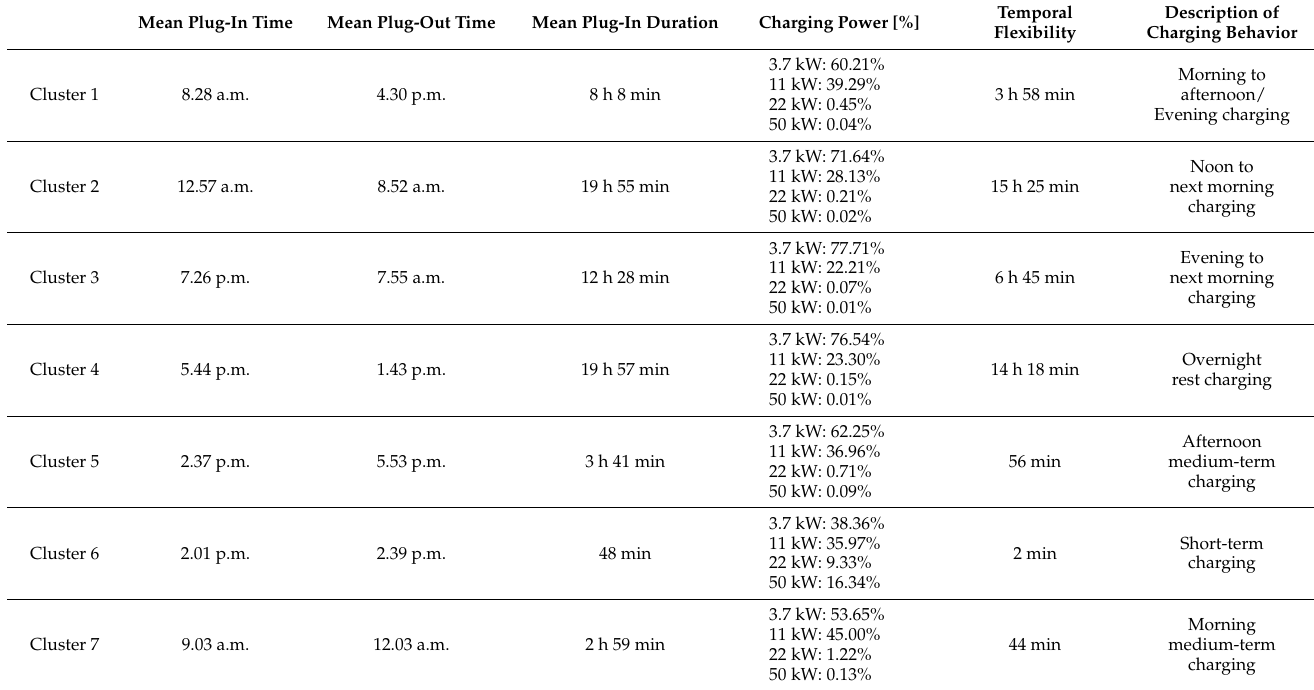
Figure 8. Related Clusters to the GMM-Clustering, red dashed line represents midnight. Table 1. Characteristics of the temporal charging